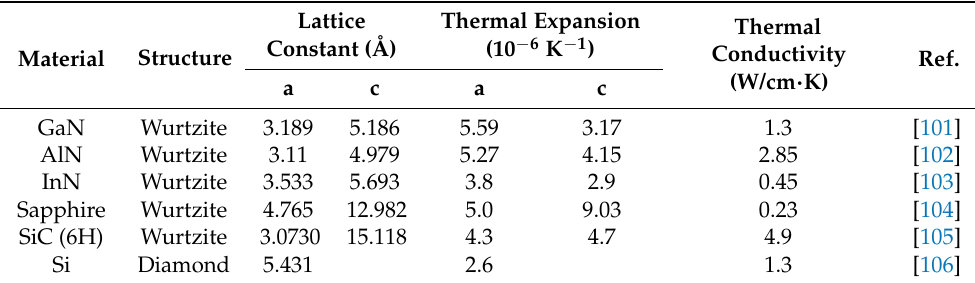
Table 3. Basic epitaxy parameters of III-nitrides and conventional substrates.